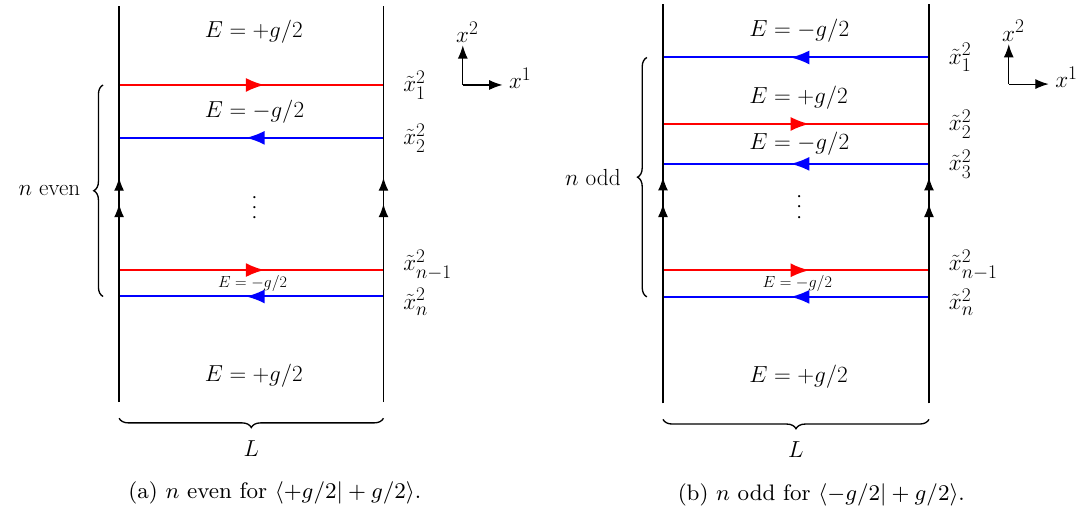
¯ ( u )) = 0 . The worldlines as solutions E ≡ E ( x i i cl